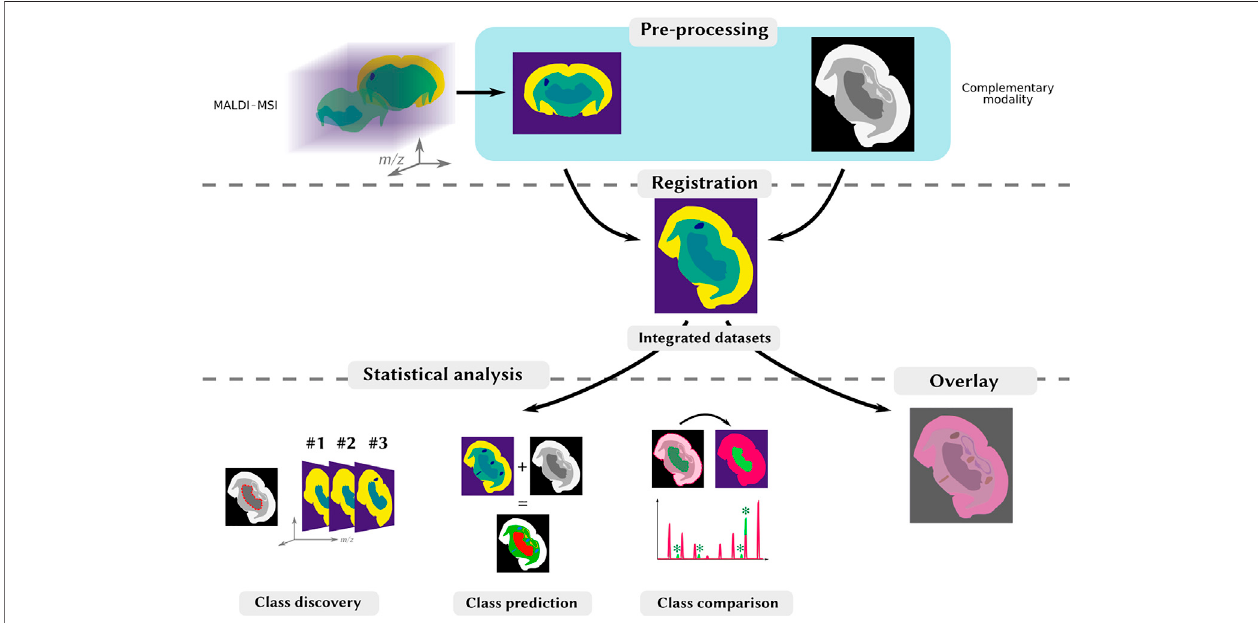
FIGURE 1 | Typical processing and analysis work fl ow for multimodal MALDI-MSI. Top-row: the MALDI image (on the left), and the complementary images (on the right) are processed so as to have comparable shapes, through various speci fi c processing steps, including segmentation. Middle-row: the images are spatially aligned throughregistration.Bottom-row:oncetheimagesareregistered,theycanbevisualizedon-topofeachothertorevealsimilarspatialdistributions(ontheright).Patterns can be objecti fi ed byajointstatistical analysisto, e.g., fi nd spatial correlations, byinvestigating spatial clusters(class discovery),produce an enriched dataset from both modalities (class prediction) or fi nd region-speci fi c ions in two different ROIs (class